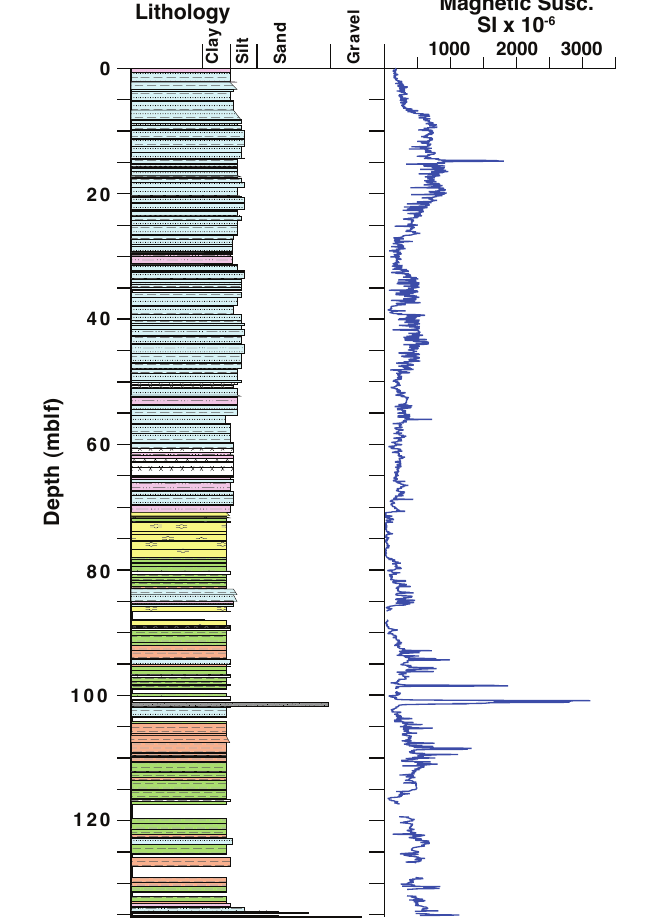
Figure 7. Summary stratigraphy of core TDP-TOW15-2A, based on initial core descriptions, and magnetic susceptibility data mea- sured on the whole (unsplit) core from the Geotek MSCL. The key to the lithologic symbols is given in Fig. 6.